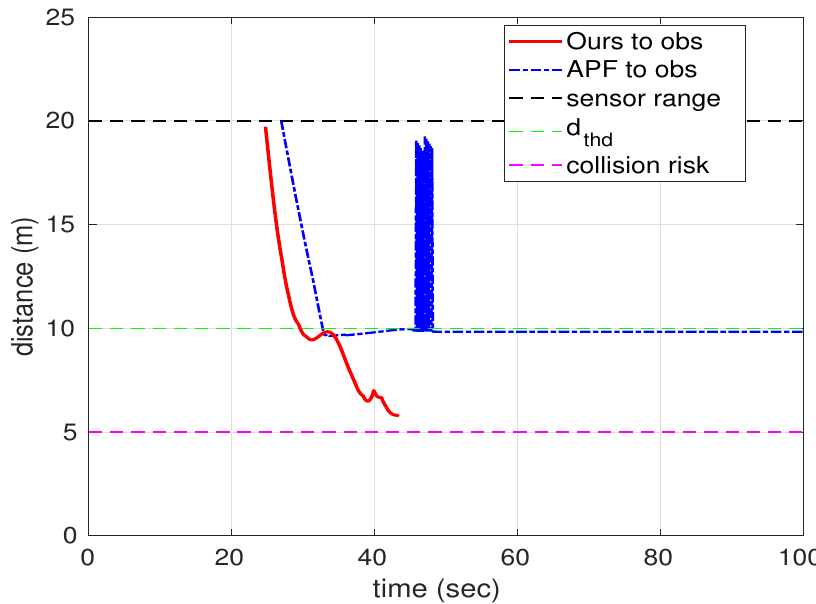
Figure 9. Relative distance to the nearest obstacle in the GNRON problem case.